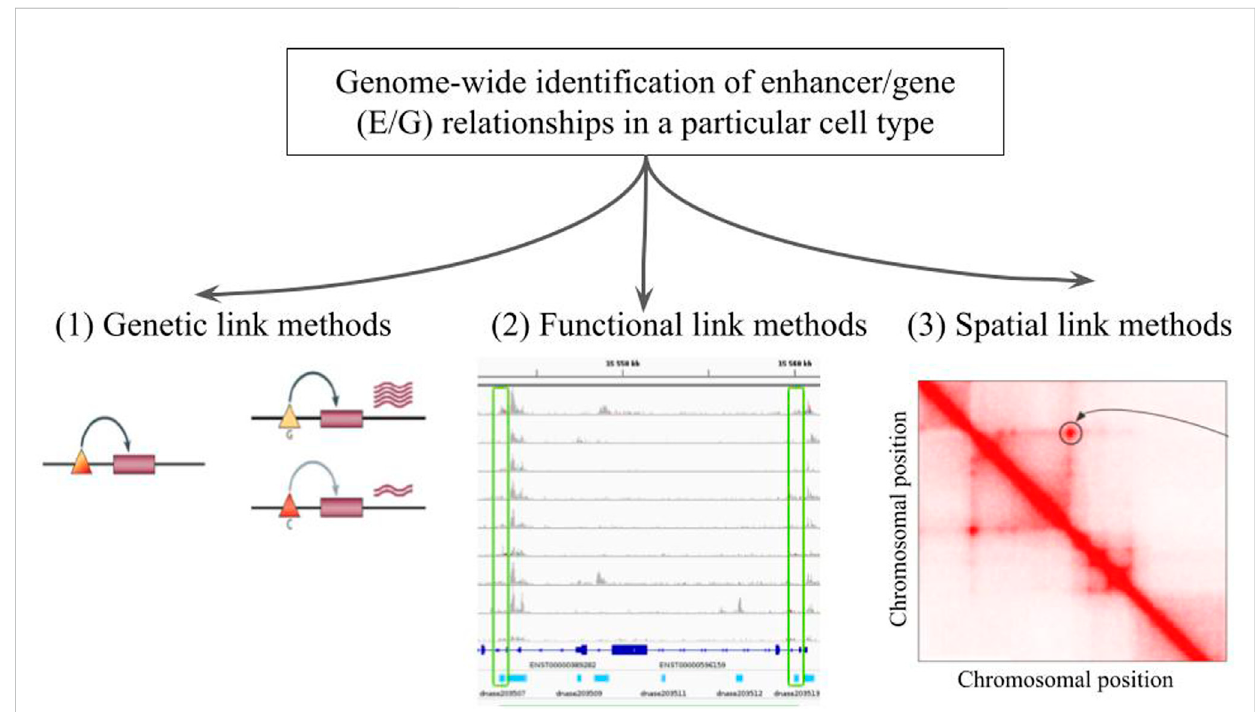
FIGURE 1 The genome-wide identi fi cation of enhancer/gene (E/G) relationships in a particular cell type. Illustration of the three broad approaches that have been described in the literature: (1) genetic link methods, (2) functional link methods and (3) spatial link methods. In panel (1) taken from Cheung and Spielman (2009), the triangles and rectangles represent genetic variants and genes, respectively. When the variant is G the gene is highly expressed, and when it is C the gene is lowly expressed. This variant is said to be an eQTL of the gene, and if located in an enhancer the relationship between the variantandthegenebecomesanE/G.Panel(2)illustratesatypicalheuristicfunctionallinkmethod,whichcorrelateschromatinaccessibilityinpromoters and enhancers across several cell types and is described in more details in Figure 2 below. Panel (3) represents a squared heatmap where both the horizontal and the vertical axes represent the same portion of the genome divided into equal size bins. The darker the red in the cell, the closer the two regionsinthe3DspaceofthenucleusaccordingtoHiCdata.Apartfromthediagonal,somepointsfarfromthediagonalindicaterelationshipsthatcould be E/G if one of the bin lies in an enhancer and the other one lies at the transcription start site (TSS) or promoter of a